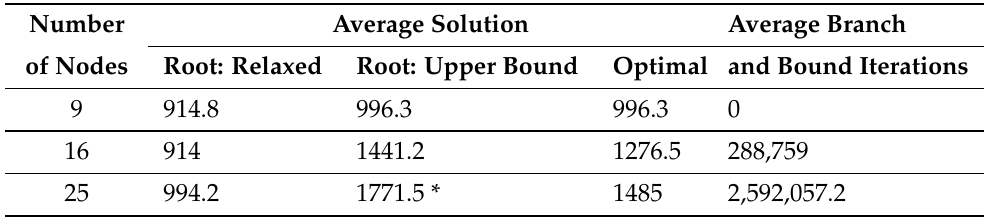
Table 8. Comparison of average relaxed solution and upper bounds in the root node for algorithm using total energy consumption index. The optimal solution is found after the number of branch and bound iterations presented in the last column. Value marked with (*) is the mean of 4 of 6 cases as CPLEX did not provide an initial approximation in the root node for all